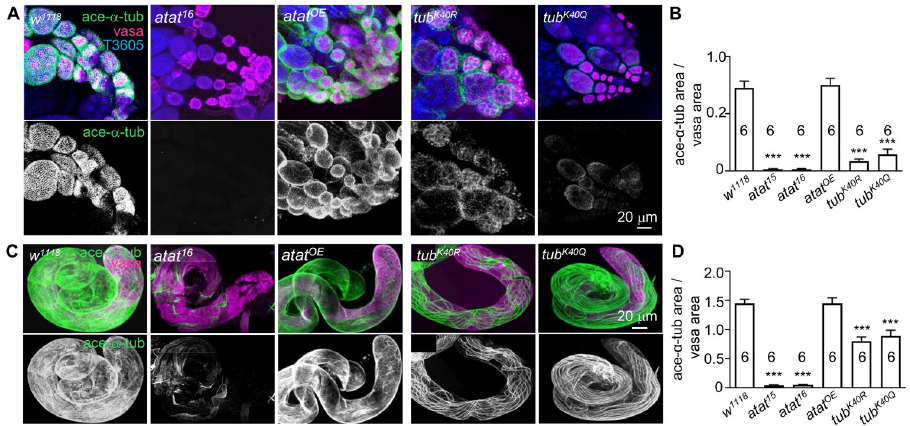
Fig 3. Atat is not the sole α -tubulin acetyltransferase in the adult testes. (A) Triple-staining of adult ovaries of control ( w 1118 ), atat 16 , and Atat overexpression driven by vasa-Gal4 ( atat OE ), α 1-tubulin K40R ( tub K40R ), and α 1-tubulin K40Q ( tub K40Q ) with anti-acetylated α -tubulin (green), anti-vasa (magenta, labels germ cells) and DNA dye TO-PRO(R) 3 iodide (T3605, blue). Scale bar: 20 μ m. (B) Quantification of acetylated microtubule densities. Mean ± SEM. One-way ANOVA with Tukey’s multiple comparisons test. ��� p < 0.001. (C) Adult testes stained with anti-acetylated tubulin (green) and anti-vasa (magenta) to show microtubule network and germ line cells. Scale bar: 20 μ m. (D) Quantification of acetylated microtubule densities. Mean ± SEM. One-way ANOVA with Tukey’s multiple comparisons test. ��� p < 0.001.